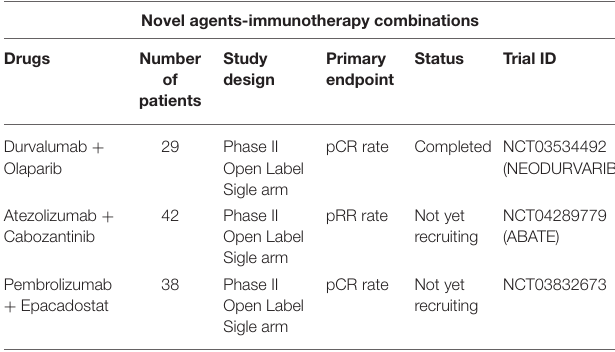
TABLE 4 | Overview of selected neoadjuvant trials in MIBC testing immunotherapy combined with novel therapeutic